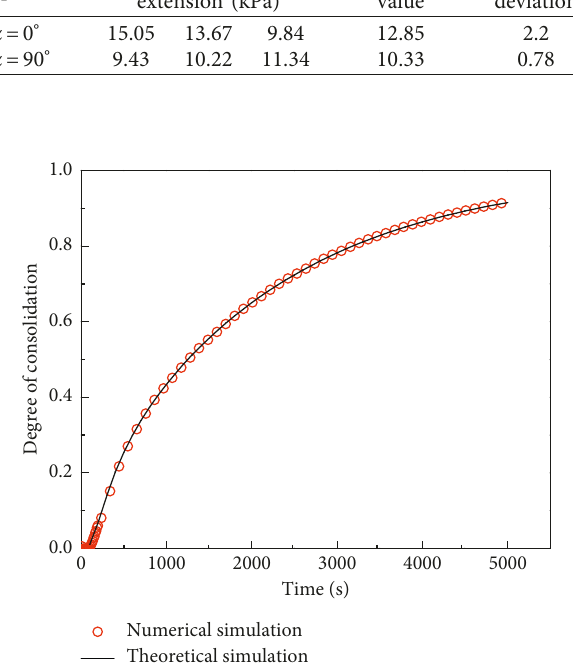
Figure 10: Comparison between theoretical solution and nu- merical simulation.